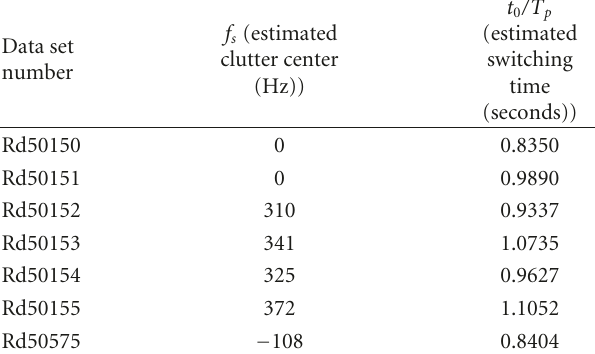
Table 1: Clutter center estimate for several MCARM data sets and the corresponding optimal switching time